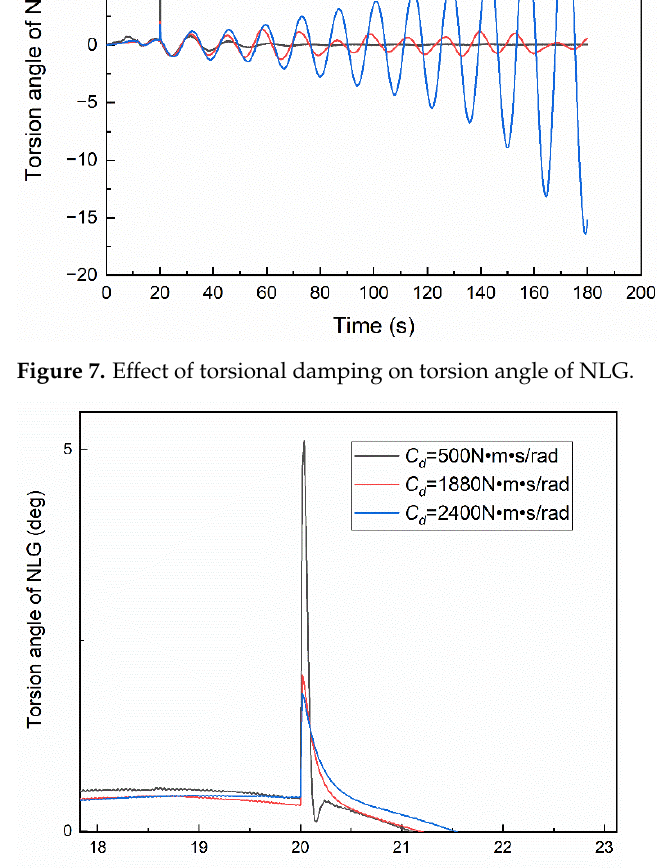
Figure 8. Torsion angle of NLG with different torsional damping under the same initial excitation. The yaw rate can directly reflect the direction stability of the aircraft during the taxi- ing process. If the taxiing direction of the aircraft is stable, the yaw rate of the aircraft must tend to 0; otherwise, there will be a yaw trend. Figure 6 shows the yaw rate of the aircraft under different torsional damping: when the torsional damping is 1880 N m s/rad, the yaw rate of the aircraft is approximately stable and oscillates within the amplitude of 0.01 deg/s; when the torsional damping is greater than the critical value, the yaw rate increases gradually, the vibration diverges and the direction of the aircraft is unstable; when the torsional damping is less than the critical value, the yaw rate of the aircraft gradually de- creases to 0, the vibration converges and the direction of the aircraft is stable. Figure 7 presents the time-domain curves of the torsion angle of NLG under different torsional damping, which is the same as the yaw rate of the aircraft: when the torsional damping is 1880 N m s/rad, the torsion angle of the NLG is approximately stable and oscillates within the amplitude of 1.5 deg; when the torsional damping is greater than the critical value, the vibration diverges, otherwise, the vibration converges. At the same time, it can also be observed in Figure 8 that under the instantaneous excitation of the left front wheel of 25,000 N, the initial torsion angle is different under different torsional damping. When the torsional damping is 500 N m s/rad, the initial torsional angle is 5 deg, so the smaller the torsional damping, the weaker the anti-interference ability. All of the above reflect the relationship between torsional damping and aircraft directional stability, which lays a foundation for further obtaining the critical torsional damping value. 3.2. Characteristics of Key Parameters in the Aircraft Taxiing Process Little work has been performed on the characteristics of aircraft taxiing direction un- stable self-excited vibration key parameters. Based on the established MBD model, this paper carries out related research, which is helpful for readers to deeply understand the process of aircraft's taxiing direction unstable self-excited vibration. 3.2.1. Initial Excitation During the taxiing process of the aircraft on the airport runway, due to factors such as uneven road surface or crosswind, the initial excitation of the aircraft varies and is ran- dom. Figure 9 shows the influence of different initial excitations on the stability of the aircraft taxiing. When the torsional damping is 1880 N m s/rad, the time domain curves of the torsion angle of NLG under different initial excitations are obtained. The larger the excitation, the larger the initial torsion angle. Although there are fluctuations in the three